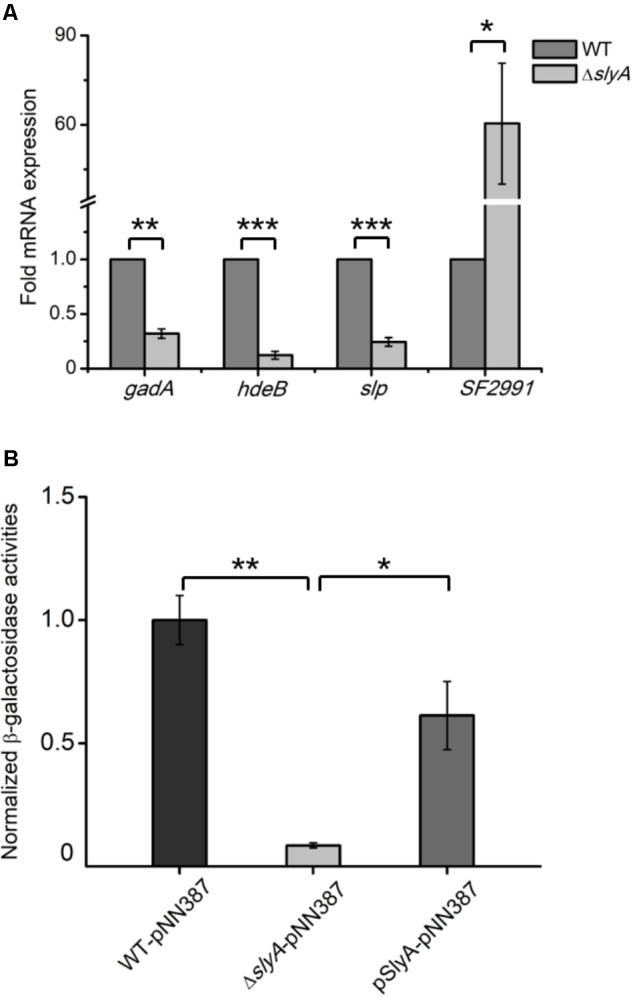
SlyA activates the expression of gadA at the transcriptional level. (A) qRT-PCR analyses of mRNA samples extracted from Shigella WT and ΔslyA strains. (B) Measurements of β-galactosidase activities in WT, ΔslyA, and ΔslyA+pSlyA strains harboring a plasmid encoding a promoterless lacZ fused with the gadA promoter. β-Galactosidase activities from three biological replicates are shown with values normalized to that of the WT strain. Asterisks indicate significant differences (∗p < 0.05, ∗∗p < 0.01, and ∗∗∗p < 0.001).